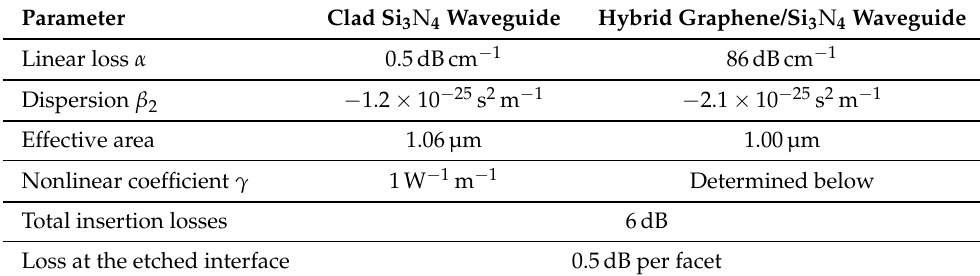
Table summarizing the parameters of the clad Si 3 N 4 waveguide and the hybrid graphene/Si 3 N 4 , as used in the simulations.